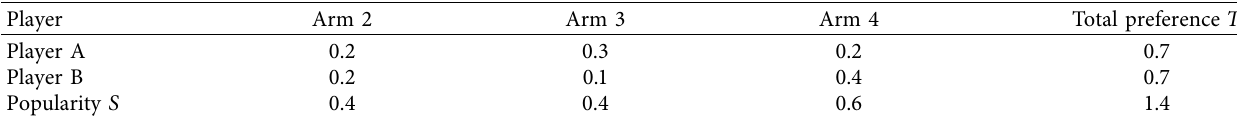
Table 5: Preference profle for the remaining part in [Case